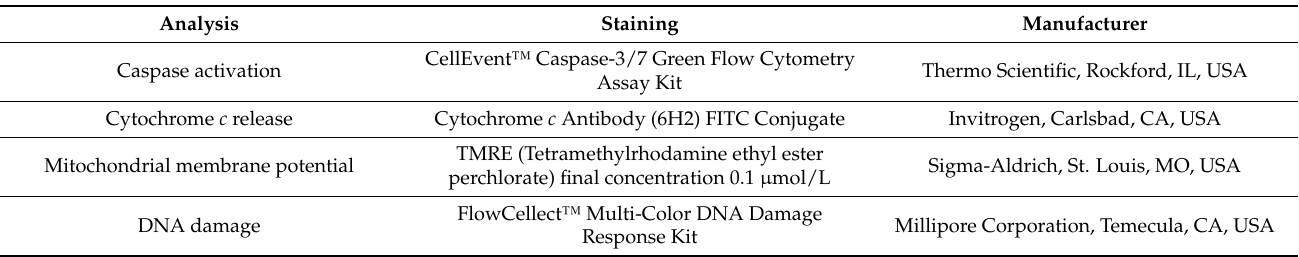
Table 5. Flow Cytometry